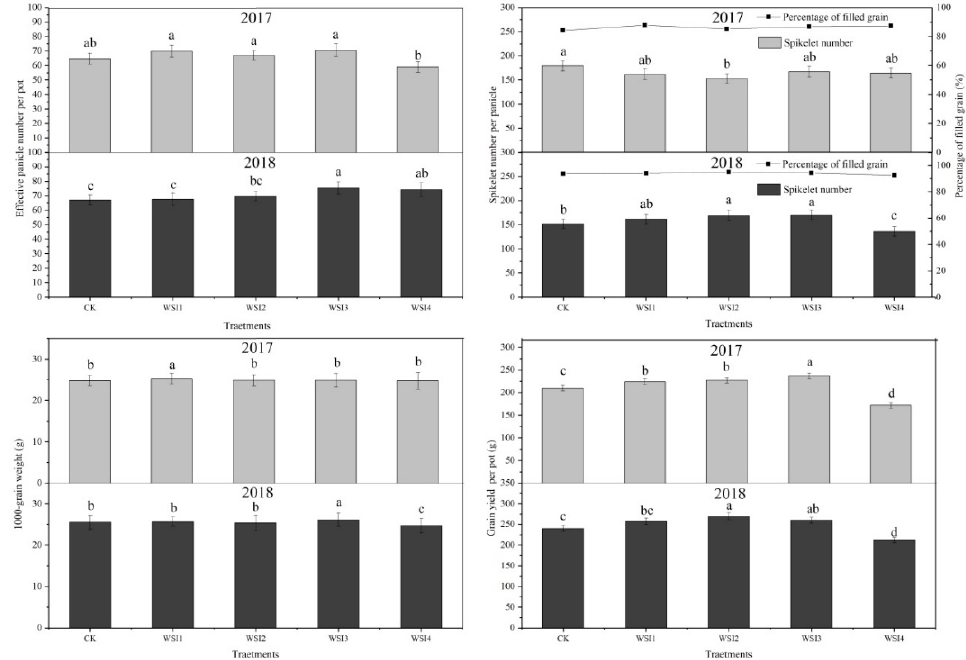
Figure 6. Grain yield and its components of different irrigation regimes in 2017 and 2018.